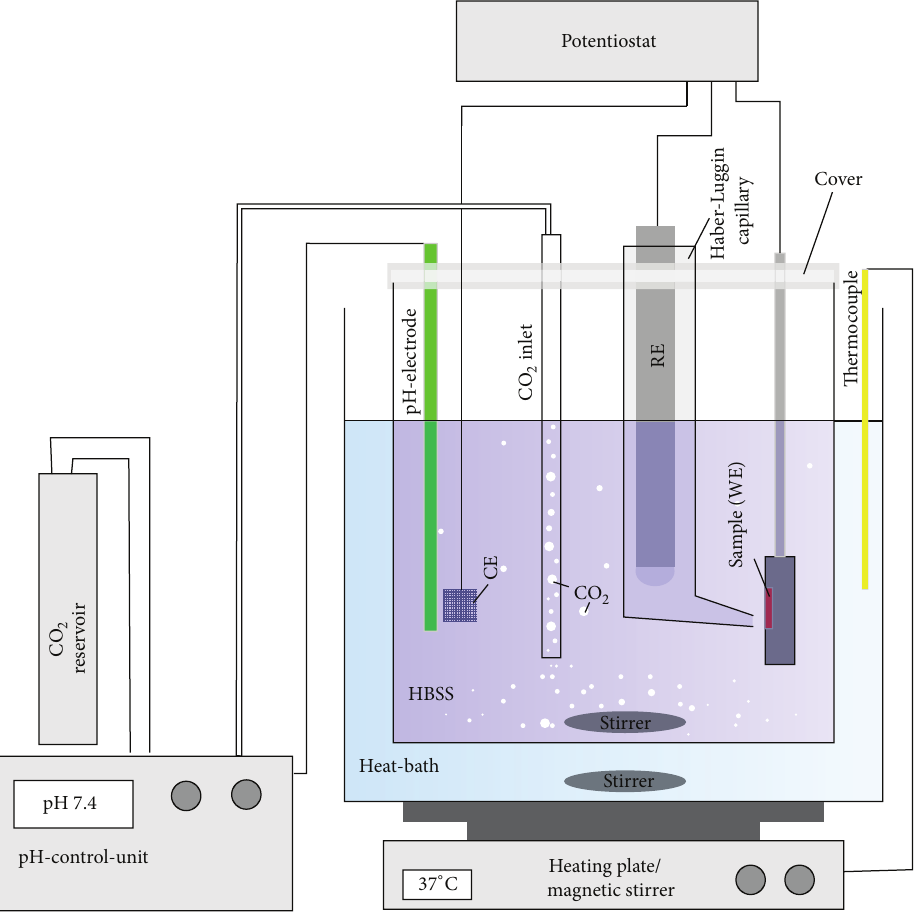
Figure 2: Schematic sketch of the corrosion measurement. A standard three-electrode setup is placed in the corrosion cell filled with Hank’s buffered salt solution. The temperature is held at 37 ∘ C by a heating bath. By measuring the pH-value CO 2 inlet regulation the pH value of the solution is constantly kept at 7.4.